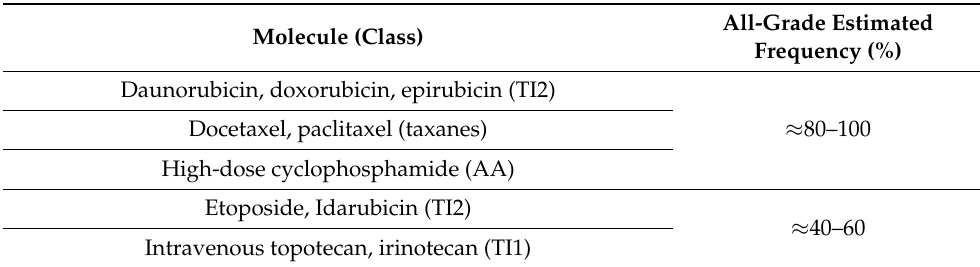
Table 3. Main chemotherapy molecules used against solid tumors and their corresponding frequency of alopecia (adapted from references